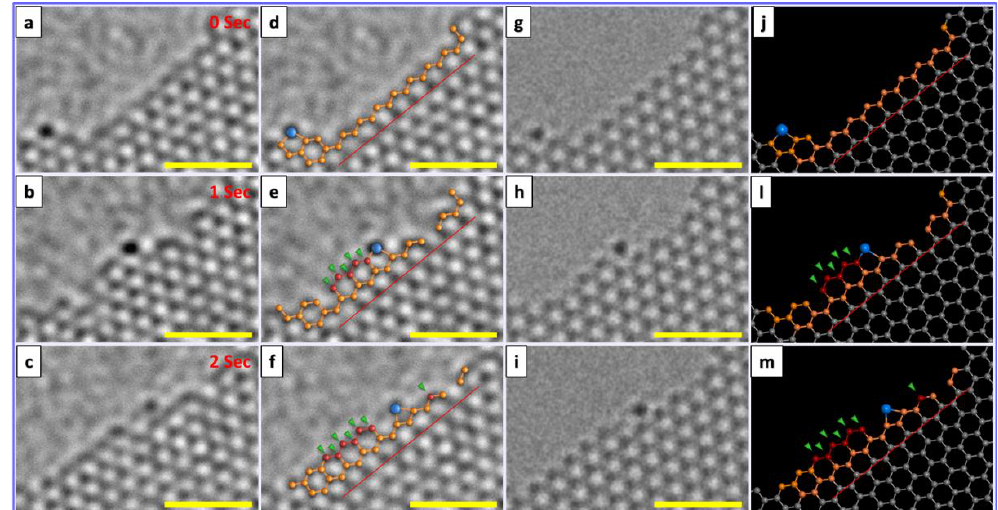
Figure 5. Electron beam driven catalytic growth of graphene by a single Cr atom at the graphene edge. ( a – c ) HRTEM images showing in-situ growth process; ( d – f ) with partial stick and ball models to assistance viewing; ( g – i ) image simulations showing the growth process; ( j – m ) complete stick and ball models. Blue balls are designated to Cr while red balls and green arrows signify new C atom. All scale bars are 1 nm. Reproduced with permission from Ref. [46] Copyright (2017), Tsinghua University Press and Springer-Verlag GmbH Germany.